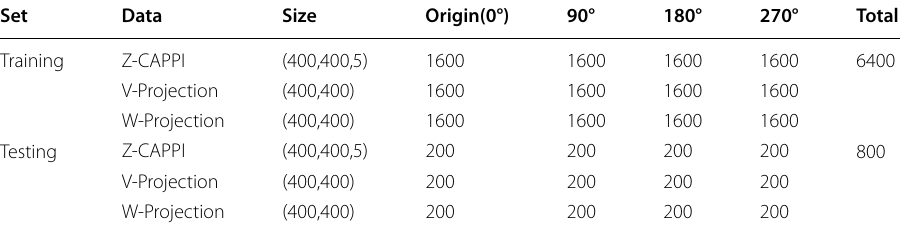
Table 2 The datasets used in the experiments